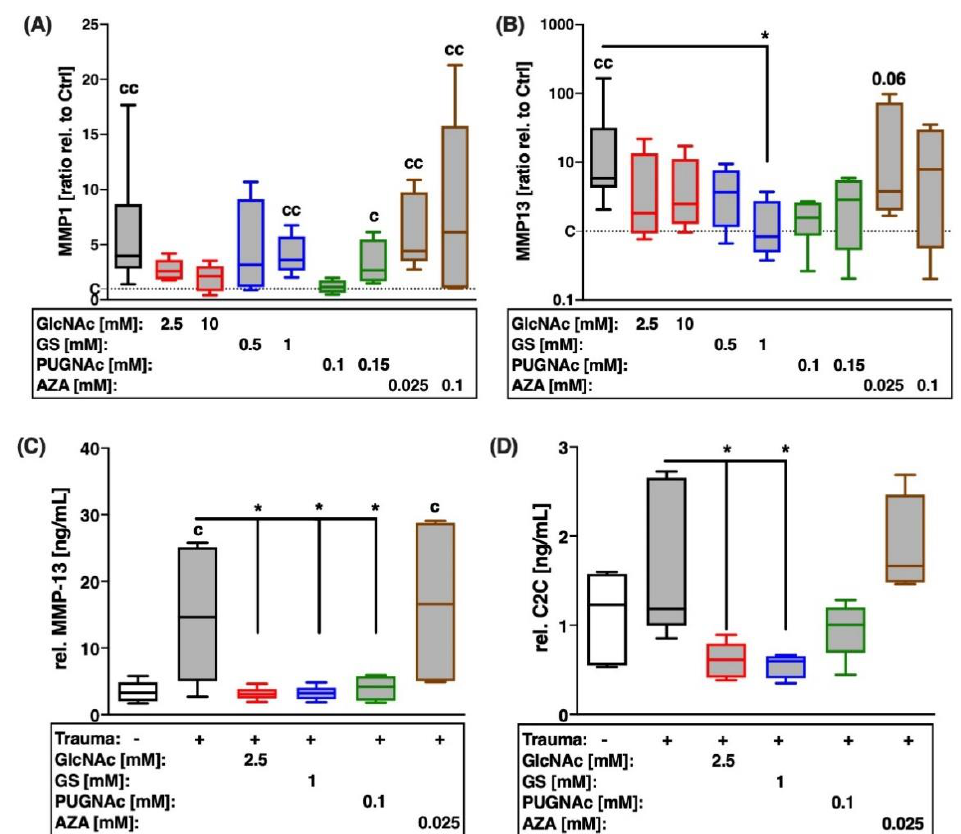
Figure 5. Effects of glucosamine treatment or addition of inhibitors on trauma-induced expression of collagenases and COL2A breakdown 7 days after trauma. Catabolic processes were assessed by the means of gene expression analysis of ( A ) MMP-1 and ( B ) MMP-13, as well as ( C ) quantification of MMP-13 release and ( D ) type II collagen breakdown product C2C. Statistical analysis: ( A , B ) Kruskal–Wallis test, ( C , D ) one-way ANOVA. Significant differences between groups were depicted as: [versus T] * = p < 0.05; [versus C] c = p < 0.05, cc = p < 0.01; all data sets n ≥ 5. Blank box = unimpacted control (C), shaded boxes = traumatized cartilage explants